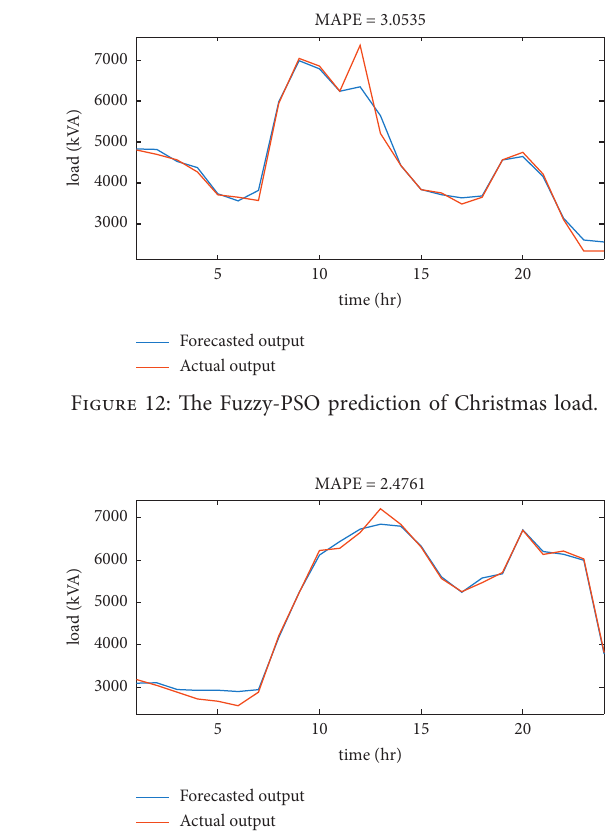
Figure 13: The Fuzzy-PSO prediction of Siqilet